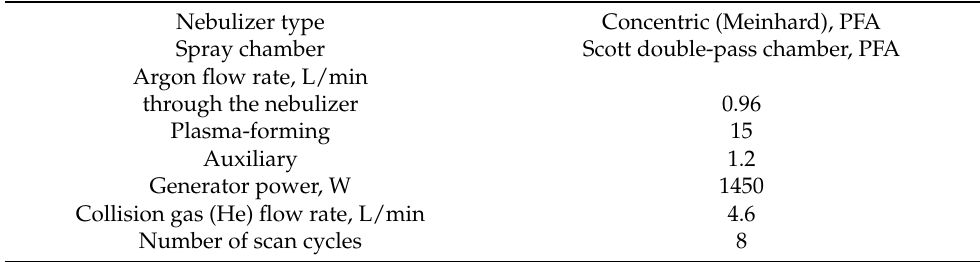
Table 2. The operating mode of the NexION300D instrument for conducting impurity analysis of samples. Nebulizer type Concentric (Meinhard), PFA Spray chamber Scott double-pass chamber, PFA Argon flow rate, L/min through the nebulizer 0.96 Plasma-forming 15 Auxiliary 1.2 Generator power, W 1450 Collision gas (He) flow rate, L/min Number of scan